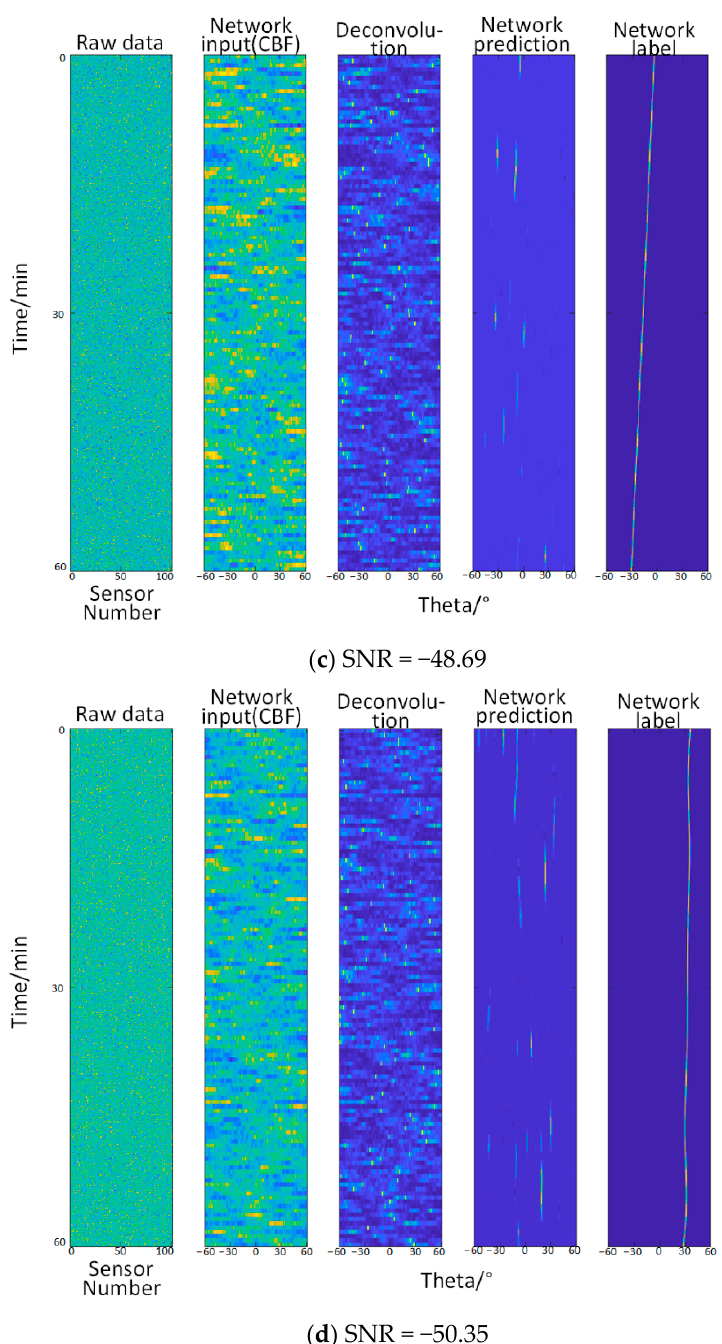
Figure 6. ( a – d ) show the angle recognition results and prediction results of training different methods under different signal-to-noise ratio conditions. ( a – d ) from left to right: original data (the abscissa is the sensor number, and the ordinate is the time), the input of the network (the abscissa is the angle, and the ordinate is the time, which is the same below), deconvolution method, the network predictions, network labels (true trajectories). After sorting out the experimental data, the concept of accuracy is introduced, that is, we correlate the prediction results of CBF, deconvolution, and U ‐ NET with the real trajectory (label), and if the error range between the result and the real trajectory is within the spatial resolution (1 degree), the prediction/recognition is considered accurate, and conversely, the prediction/recognition is wrong. Finally, the ratio of all correctly predicted